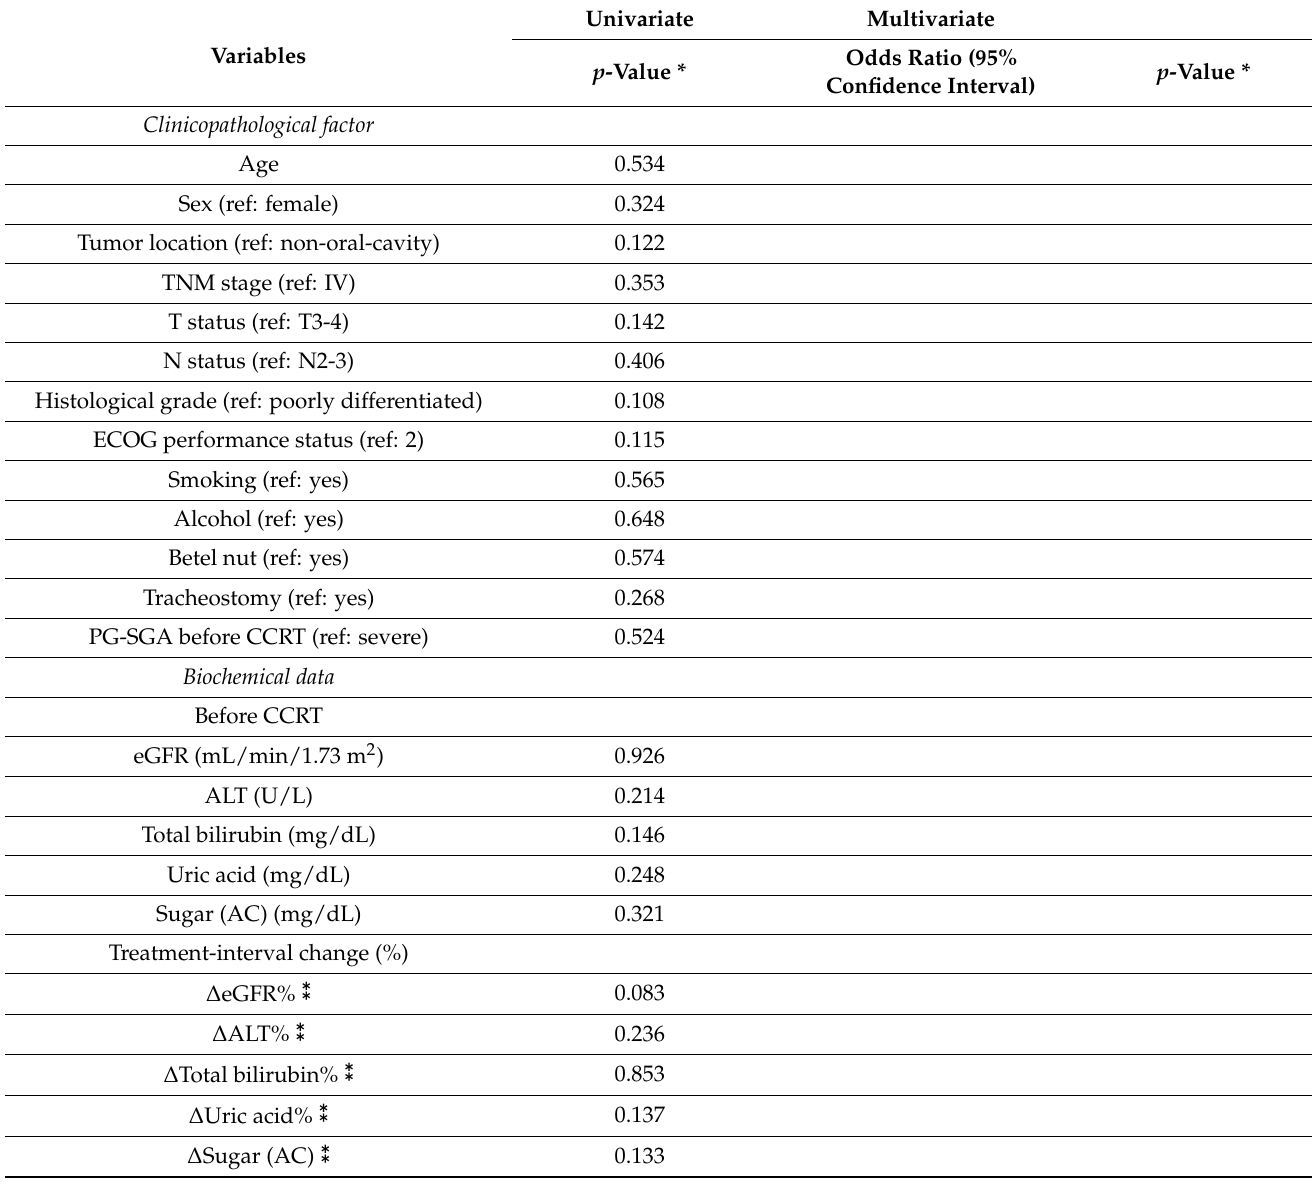
Table 4. Univariate and multivariate logistic regression analyses of risk factors associated with treatment interruption of 44 patients with LAHNSCC completing CCRT.